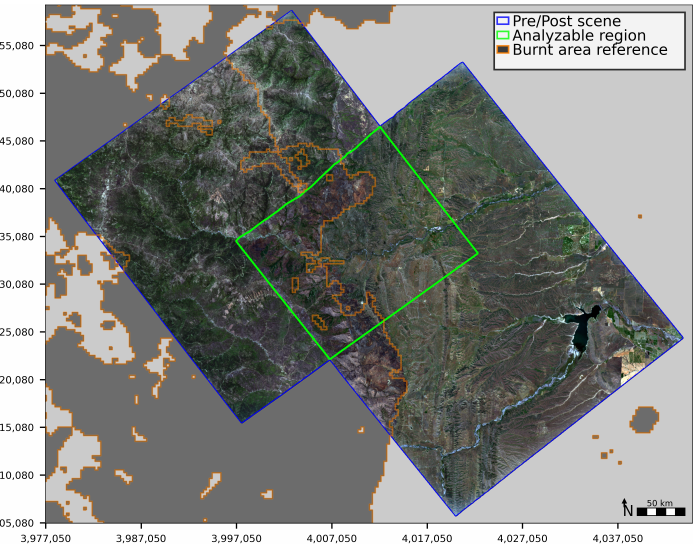
Figure 3. Exemplary pre scene (left) and post scene (right) from 9 June 2020, and 8 April 2021,